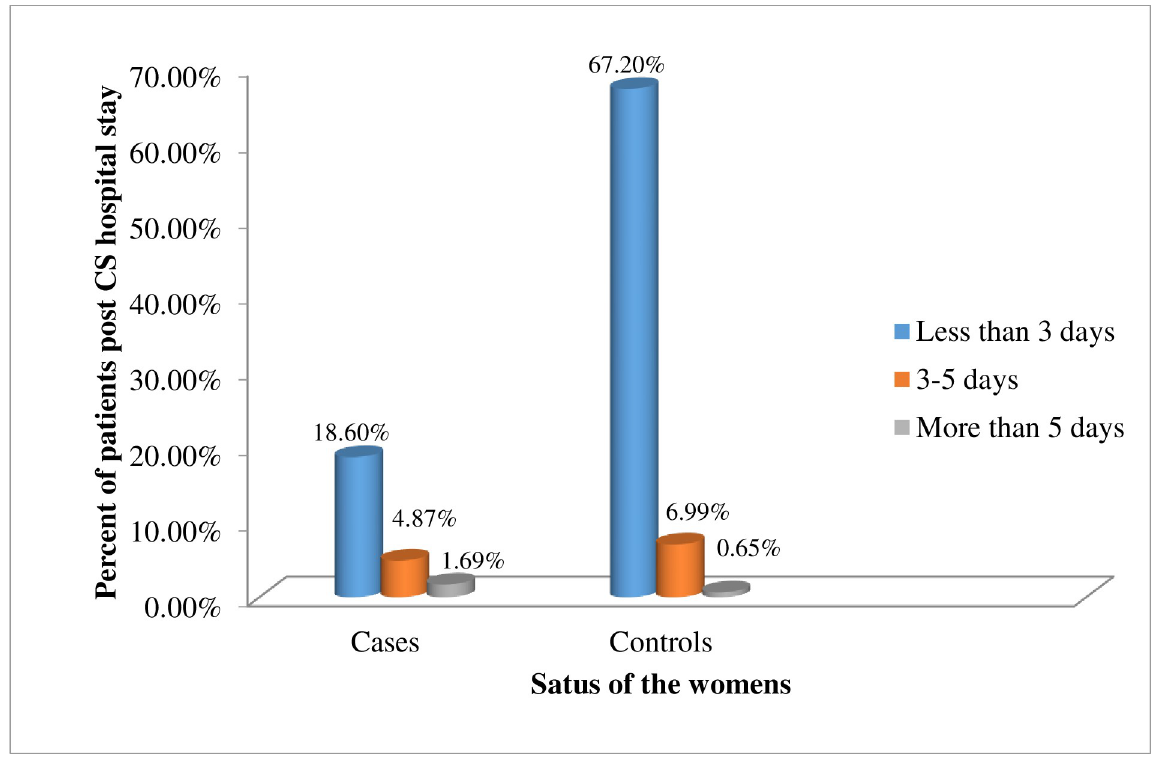
Fig 2. Proportion of women with post cesarean section hospital stay at Dire Dawa public hospitals, Eastern Ethiopia.